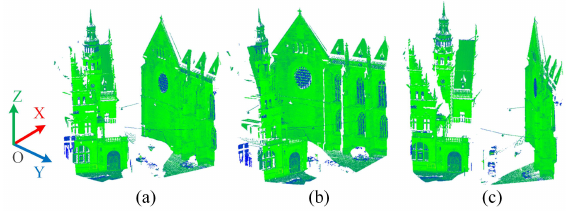
Figure 10. (a) Original point cloud. Manually rotated around Z-axis by (b) 30 ◦ and (c) -30 ◦ .